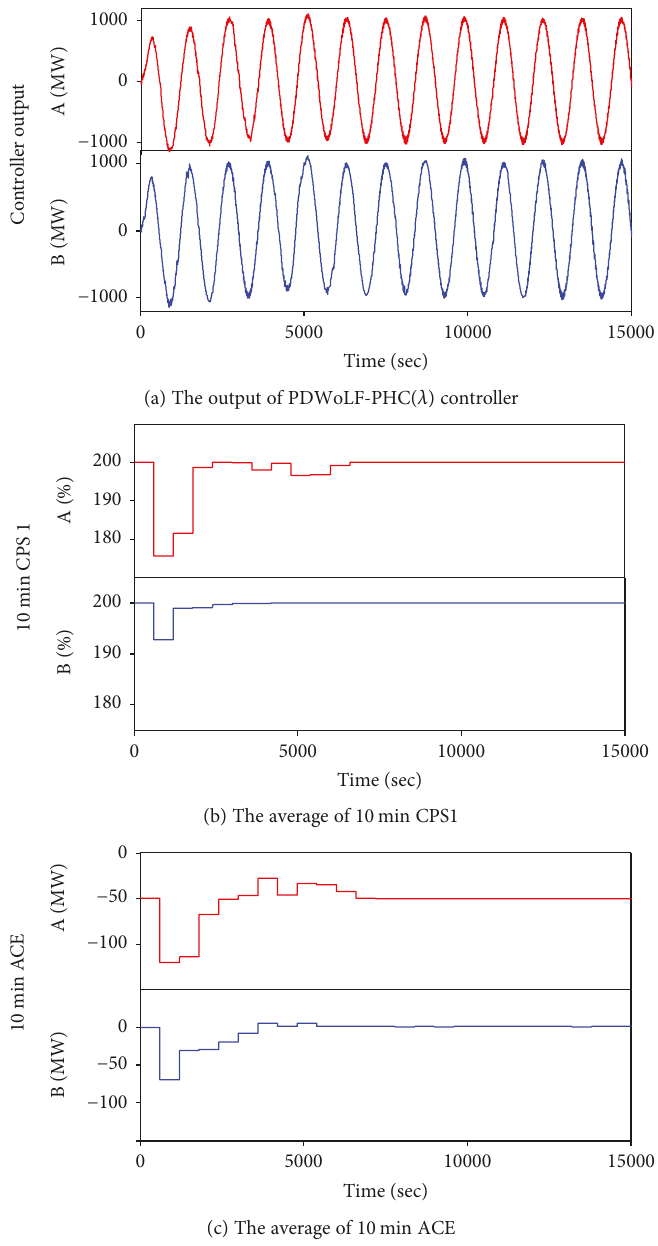
Figure 5: The prelearning of PDWoLF-PHC( λ ) obtained in the two